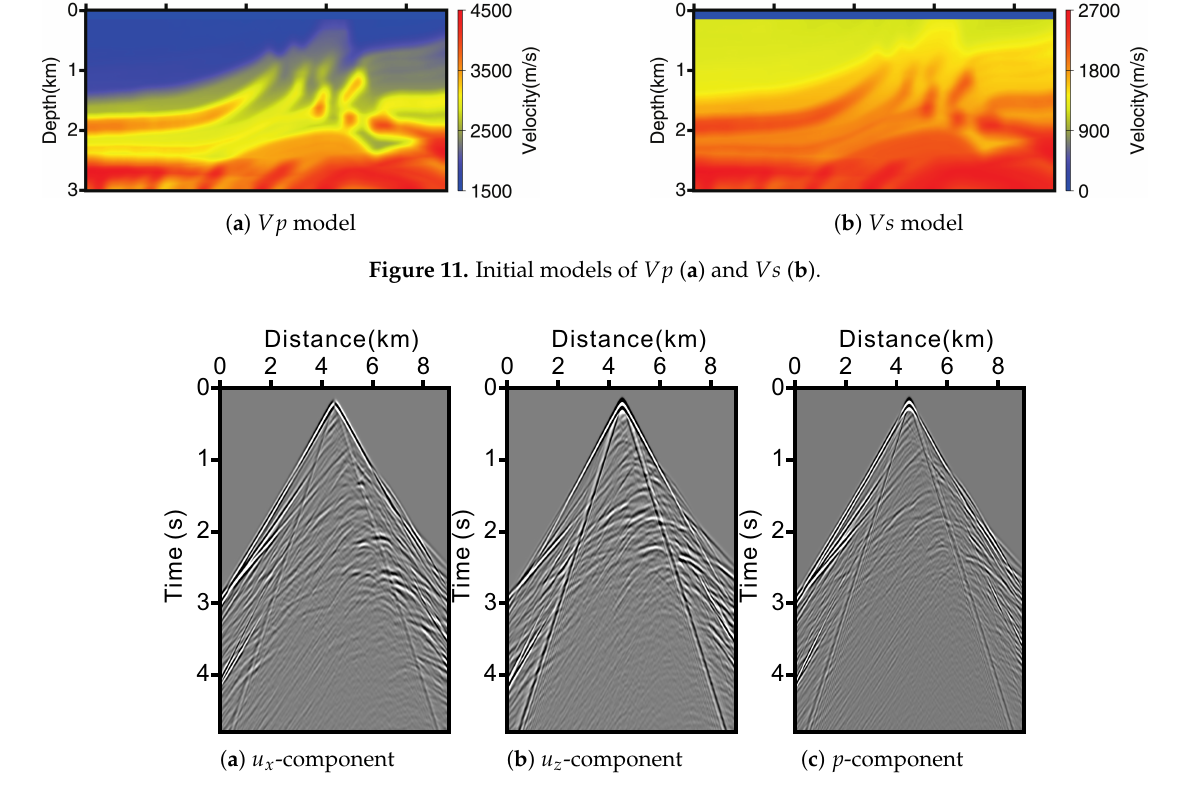
Figure 12. Observed multicomponent seismic data: ( a ) horizontal and ( b ) vertical displacement and ( c ) pressure